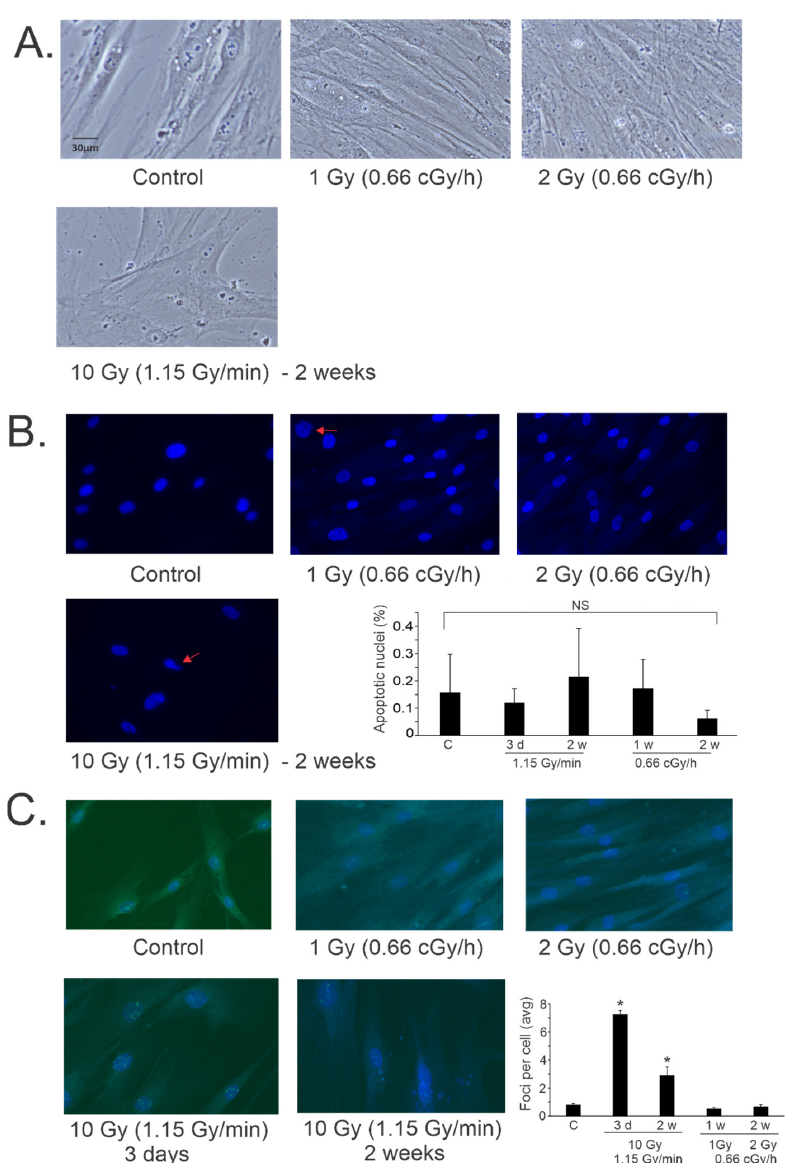
Figure 1. Effects of high and low dose-rate X-ray irradiation on cell morphology, apoptosis, and γ -H2AX foci in MSCs. MSCs were grown to 60% confluence and exposed to 60 Co irradiation at 0.66 cGy/h for 1 Gy (1 week) or 2 Gy (2 weeks). Alternatively, cells were exposed to 10 Gy X-ray irradiation (1.15 Gy/min) and assayed at 3 days and 1 week post-irradiation. Cells were fixed at the indicated times and stained with DAPI, and immunohistochemistry was performed for γ -H2AX. ( A ). Light microscopy was used to examine cell morphology. Representative images are shown, 20 × magnification. ( B ). DAPI was used to examine the nucluear morphology of the fixed cells at the indicated times. Arrows (10 Gy irradiation) indicate nuclear blebbing, a late apoptotic event. Representative images are shown from each condition, 20 × magnification. Nuclei were scored from all cells in random fields to determine percentage of apoptotic nuclei at 3 days (3 d), 1 week (1 w) or 2 weeks (2 w) post-irradiation. Graph shows average of percent apoptosis ± SEM; NS = not significant compared with control (C). ( C ). γ -H2AX immunohistochemistry was used to detect foci surrounding double-stranded DNA breaks in the fixed cells at the indicated times. Representative images are shown from each condition, 20 × magnification. Foci were scored in all cells from random fields to determine numbers of foci per cell. Graph shows average of nuclear foci ± SEM; * indicates p < 0.05 compared with sham-irradiated control